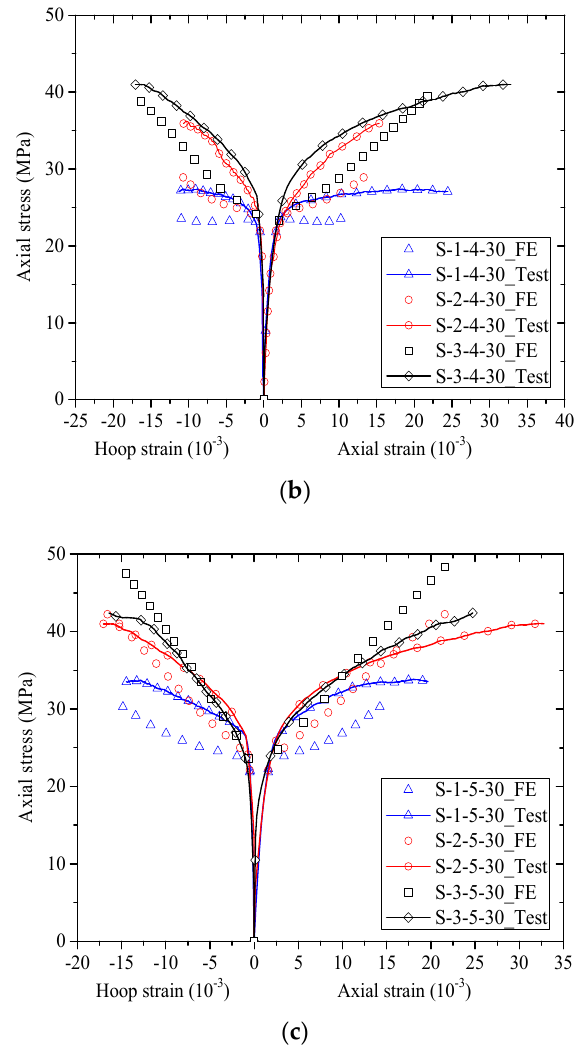
Figure 16. Stress-strain curves (experimental results versus finite element predictions). ( a ) Specimens wrapped with three strips; ( b ) Specimens wrapped with four strips; ( c ) Specimens wrapped with five strips.